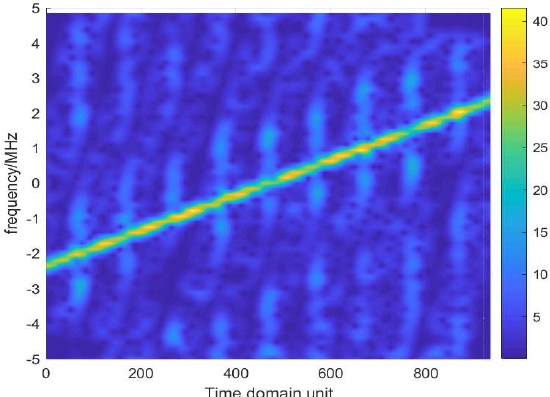
Figure 14. Time-frequency distribution of the compensated signal.